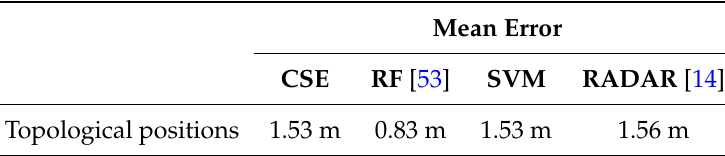
Table 1. Experimental results: test using the topological positions dataset. CSE, Continuous Space